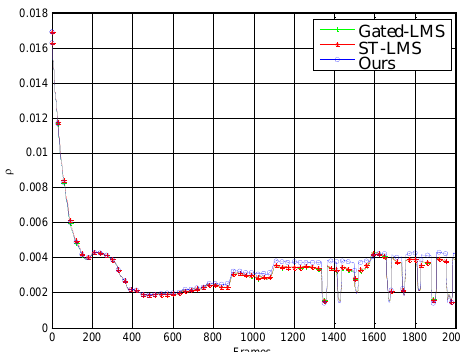
Figure 9. Roughness versus frame number for the tested algorithms using real nonuniformity data.